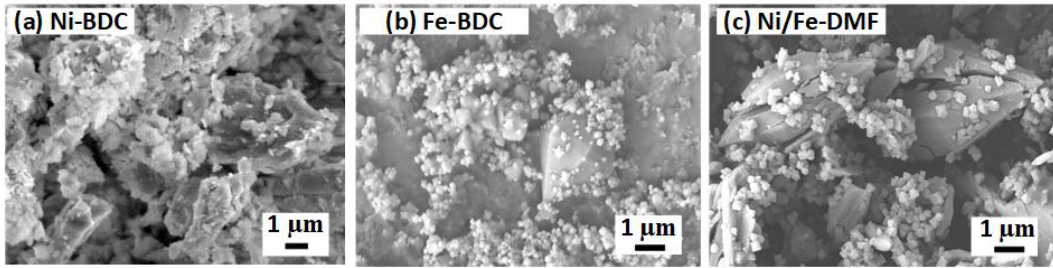
Figure 3. SEM images of Ni-1,4-Benzenedicarboxylic (Ni-BDC) (a), Fe-1,4-Benzenedicarboxylic (Fe-BDC) (b), and Fe2Ni-1,4-Benzenedicarboxylic (Fe2Ni-BDC) (c).